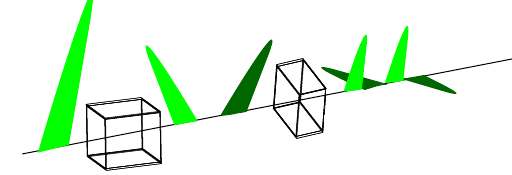
FIG. 3. Passive beam shaping by two YVO 4 birefringent crys- tals. Their optical axes are oriented at 45 (cid:7) to each other. By varying this angle, more complicated pulses can be produced in the time domain.